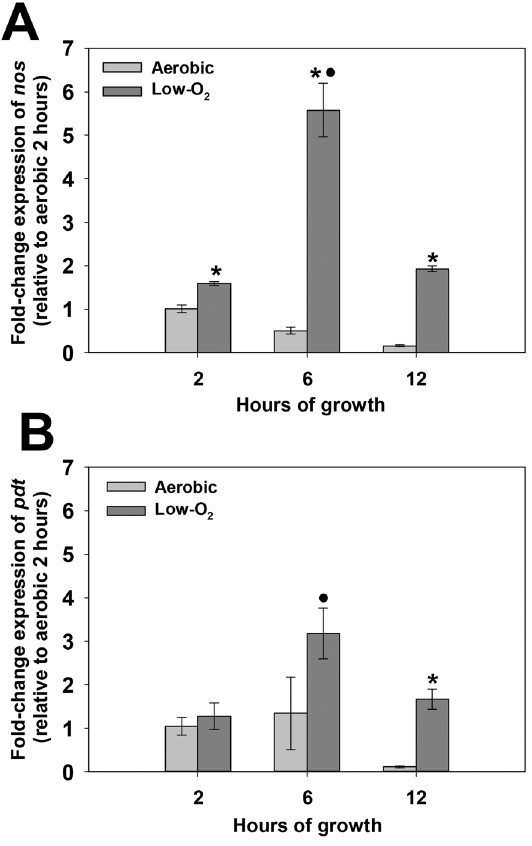
Figure 2. Growth-phase dependent nos (A) and pdt (B) expression. Total RNA was isolated at the indicated time points from n=3 biological replicates of UAMS-1 grown under highly aerated (light grey bars; 250 RPM, 1:10 volume-to-flask ratio) or low-oxygen (dark grey bars; 0 RPM, 7:10 volume-to-flask ratio) conditions. Quantitative real- time PCR was performed on reverse-transcribed cDNA from each sample using nos (A) or pdt (B) specific primers. The Livak (2 - DD Ct ) method was used to determine relative fold change of nos and pdt expression, using measured sigA expression as the reference gene and the 2 hour aerobic sample as the calibrator. Error bars = standard error of the mean (SEM). *denotes statistical significance between aerobic and low-oxygen fold-change values at each indicated time point (Two- Tailed T-Test, p , 0.01); N denotes statistical significance relative to t=2 hour low-oxygen time point (Dunnett’s Test, p , 0.05).